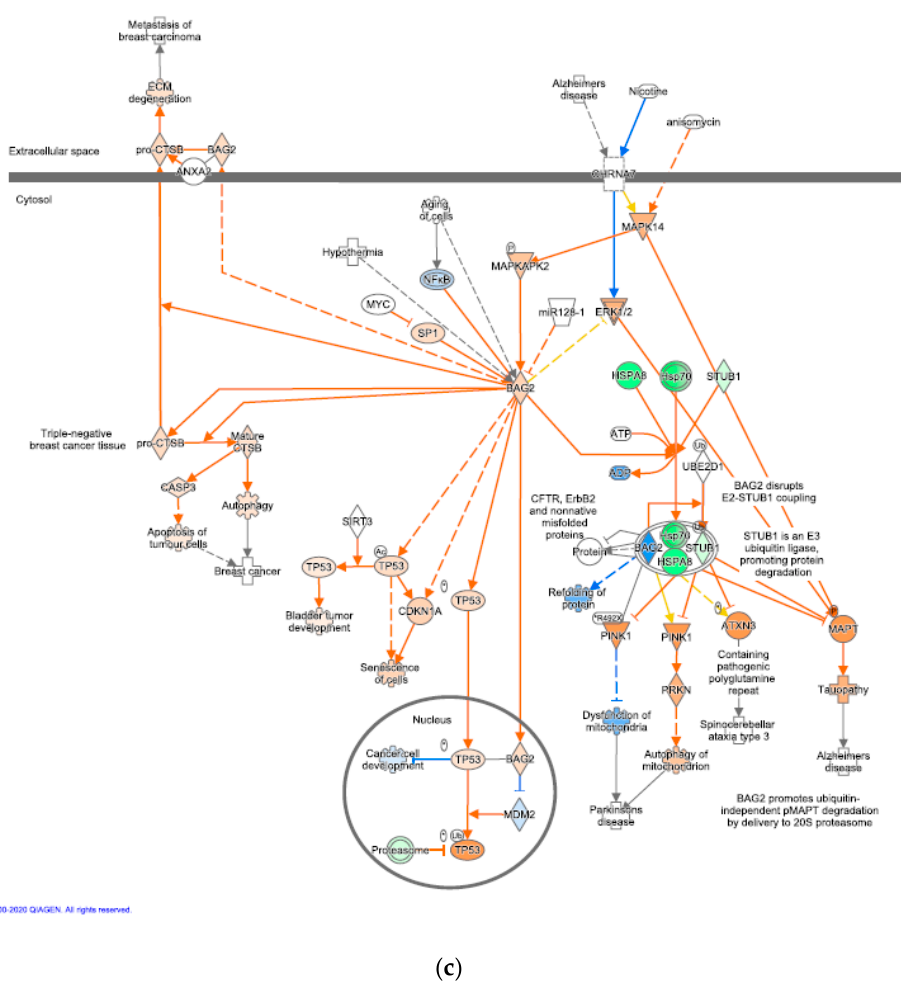
Figure 10. BAG2 signaling pathway and gene heat map in within-line comparisons with acute heat stress. ( a ) The DEG heatmap matching to the pathway; ( b ) The molecule activity prediction of the pathway in Leghorn birds with AH; ( c ) The molecule activity prediction of the pathway in Fayoumi birds with AH.